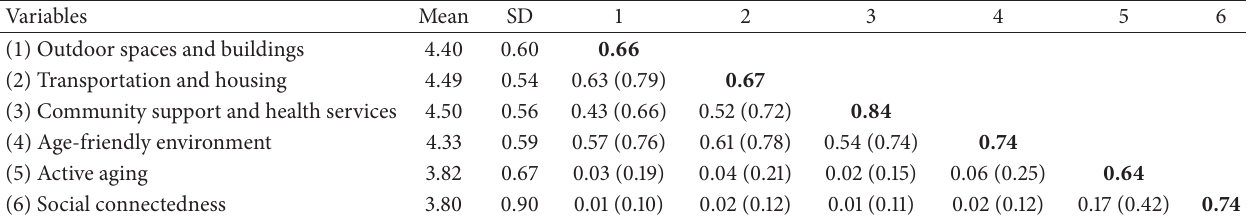
Table 5: Analysis of discriminant validity of integrated model of age-friendly environment, active aging, and social connectedness. Variables